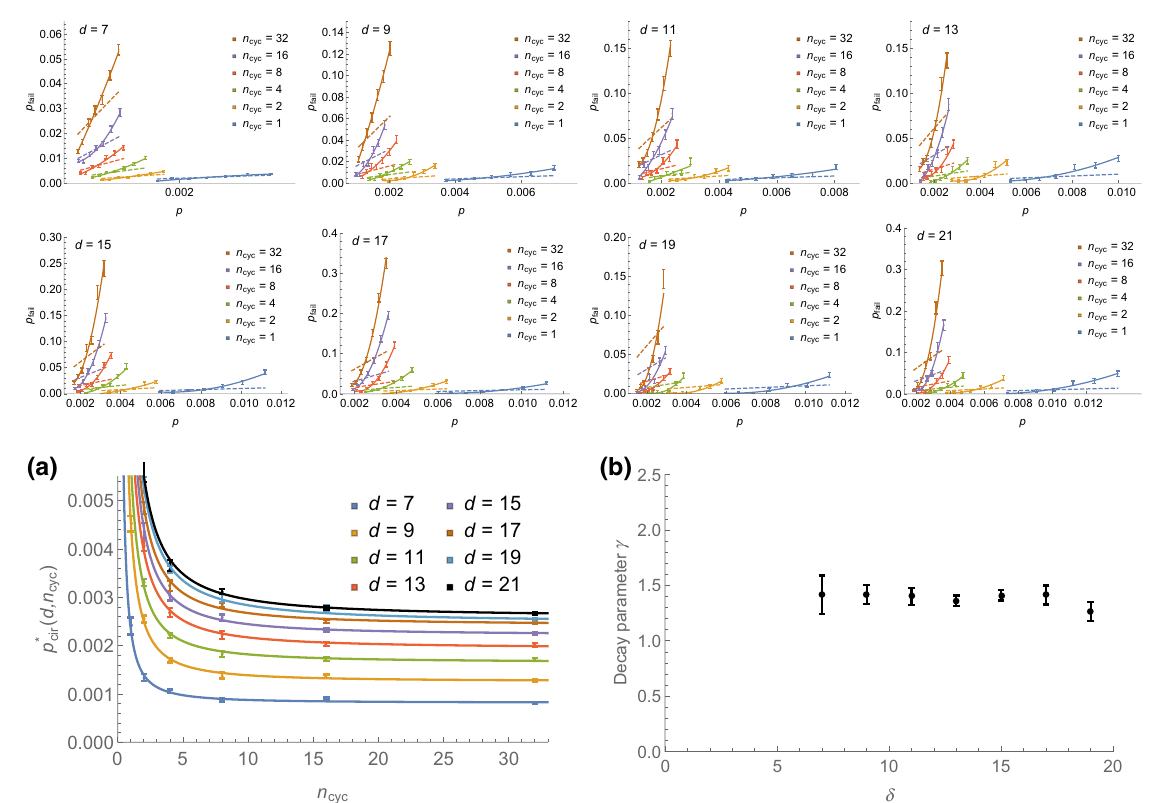
FIG. 34. (Top two rows) Failure probability of n cyc QEC cycles for circuit noise of strength p given a perfect initial state and final ( d , n ) as an intersection of quadratic fits QEC cycle, for various distances d . We estimate the time-dependent pseudothreshold p ∗ cyc cir (solid lines) with the corresponding physical qubit error probability p phy ( n cyc ) as defined in Eq. (5) in the main text (dashed curves). (a) ∗ ( d , n ) as a function of n ( d ) by fitting The time-dependent pseudothreshold p ∗ cyc cyc . We estimate the long-time pseudothresholds p cir cir ( d , n ) with the ansatz in Eq. (11) in the main text and in (b) we plot the decay parameter γ . We observe that γ stabilizes rapidly p ∗ cyc cir with increasing d , confirming that the residual noise reaches equilibrium over a time which is independent of system size.